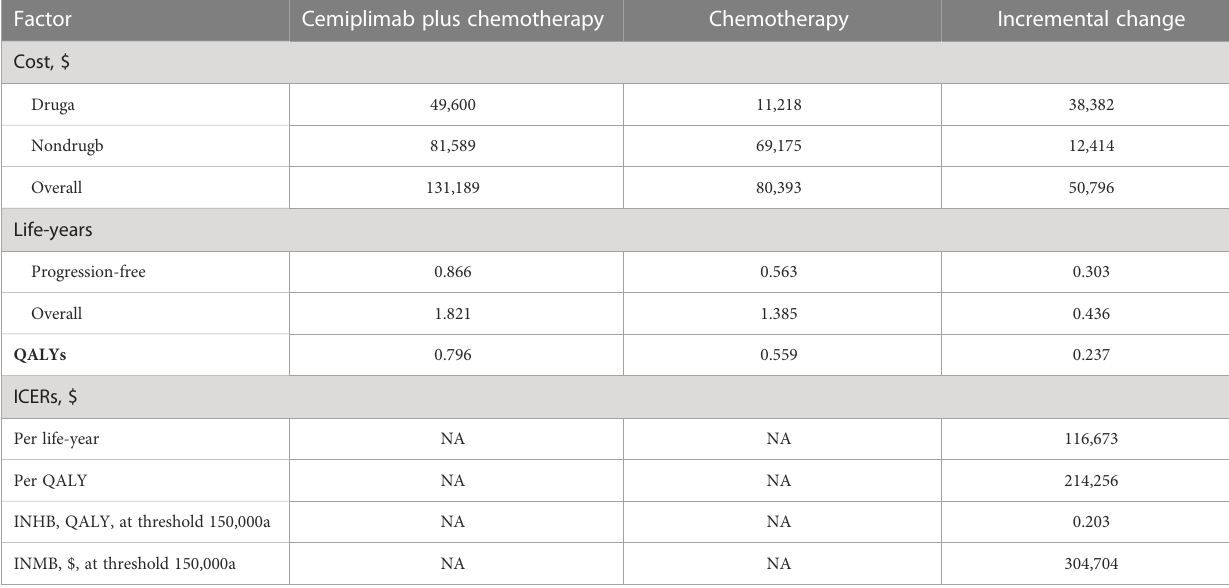
TABLE 2 Summary of cost and outcome results in the base-case analysis. Factor Cemiplimab plus chemotherapy